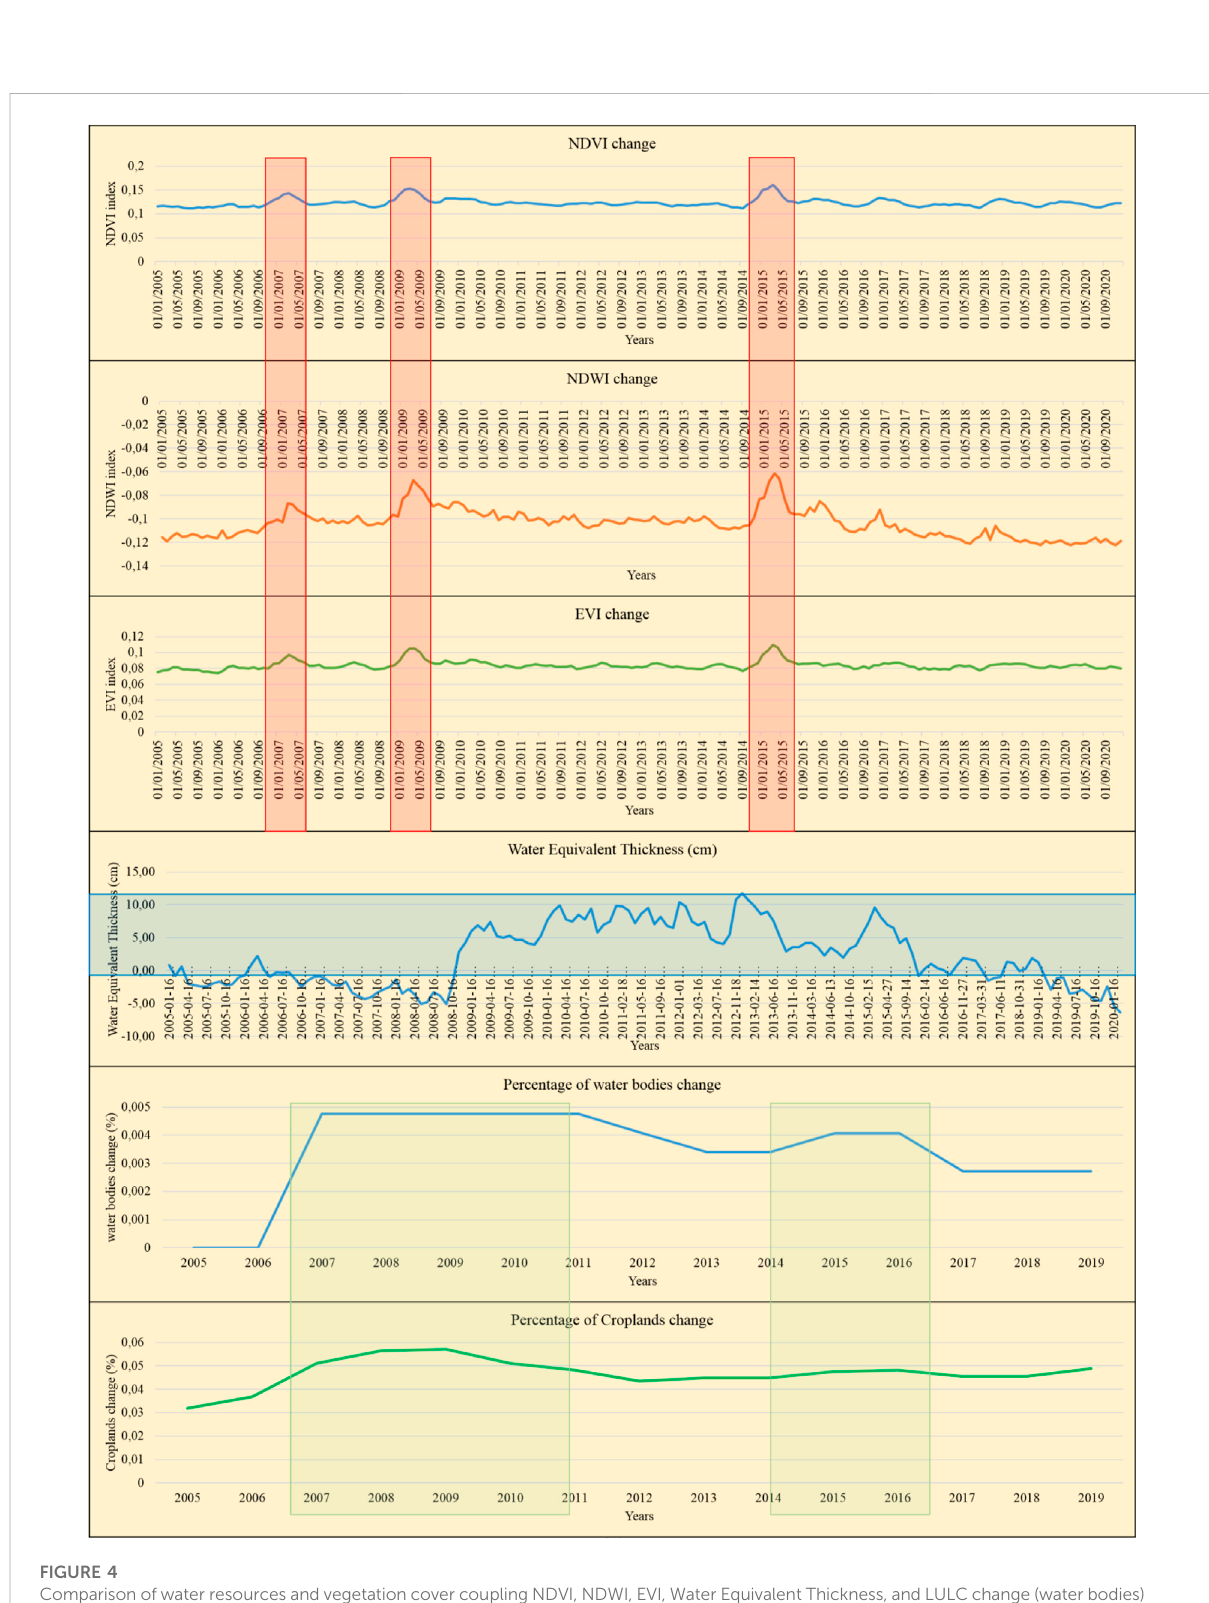
FIGURE 4 Comparison of water resources and vegetation cover coupling NDVI, NDWI, EVI, Water Equivalent Thickness, and LULC change (water bodies) in the province of Errachidia using remote sensing